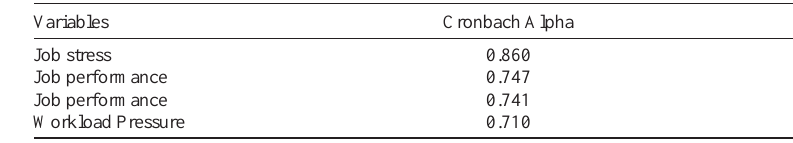
Table 5: Reliability Measures of Variables Variables